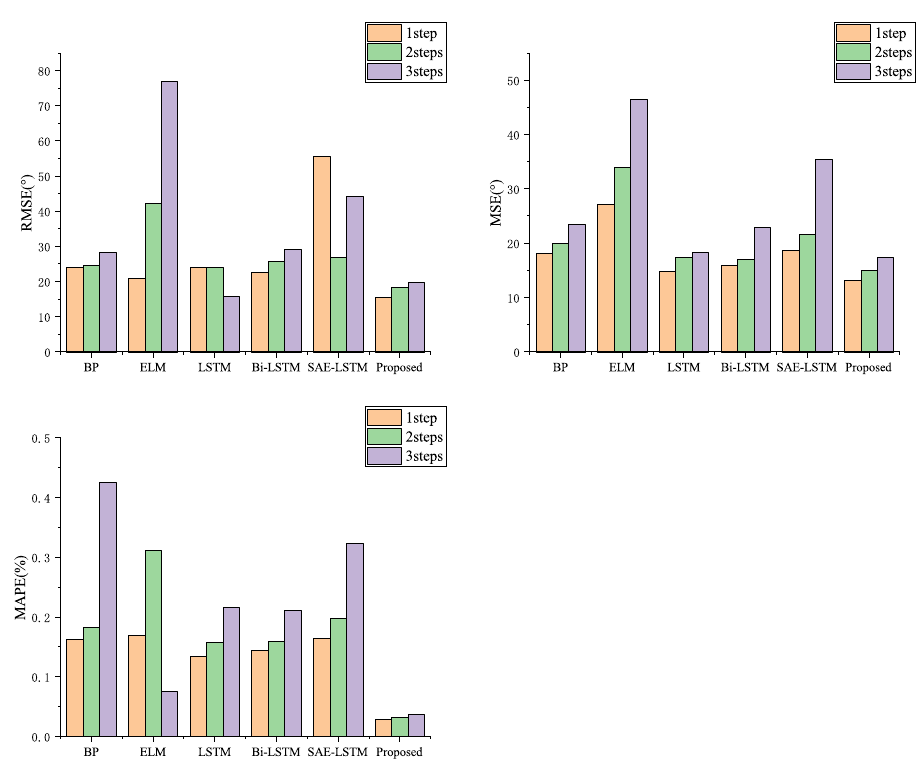
Figure 17. Roll angle prediction error distribution of Dataset